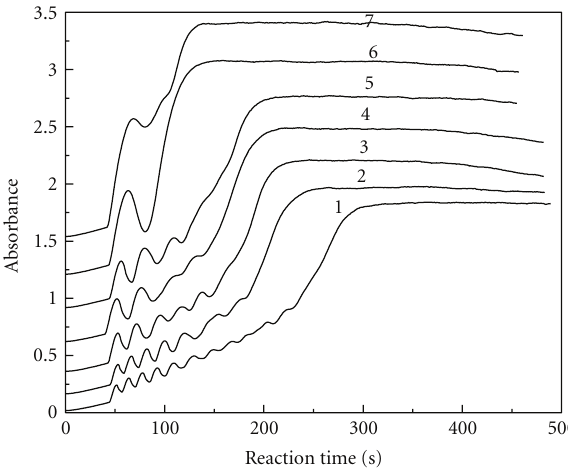
Figure 4: The absorbance versus reaction time at 289 nm for the triiodide ion: [ClO 2 ] 0 = 3.40 × 10 − 4 mol/L, [H 2 SO 4 ] 0 = 4.21 × 10 − 3 mol/L, [KI] 0 = 3.82 × 10 − 3 mol/L, [MAA] 0 = 5.66 × 10 − 3 mol/L (curve 1), 5.98 × 10 − 3 mol/L (curve 2), 6.29 × 10 − 3 mol/L (curve 3), 6.61 × 10 − 3 mol/L (curve 4), 6.92 × 10 − 3 mol/L (curve 5), 7.08 × 10 − 3 mol/L (curve 6), 7.24 × 10 − 3 mol/L (curve